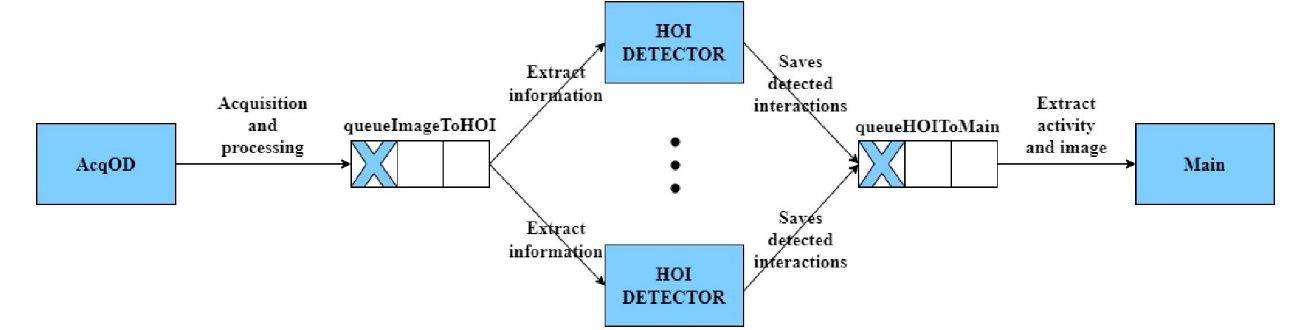
Figure 10. Communication using priority queues.